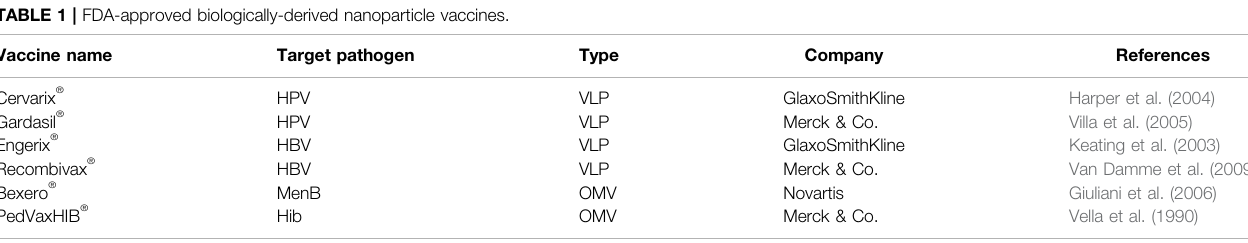
TABLE 1 | FDA-approved biologically-derived nanoparticle vaccines.